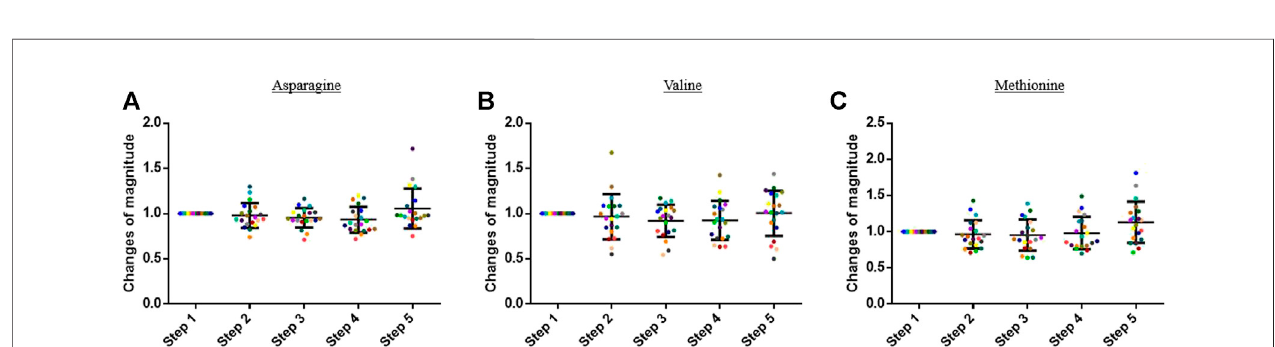
FIGURE 4 | Graphs representing the “ changes of magnitude ” obtained during the fi ve steps of the study. Step 1: before physical exercise, step 2: after 400-m warm-up and 800-m running, step 3: after the completion of 1,600-m running, step 4: 30 min after fi nishing the exercise, and step 5: 60 min after fi nishing the exercise. Each color represents one participant. Black lines represent the mean ± SD of the change of magnitude factor obtained at each step ( n (cid:2) 20). (A) Asparagine, (B) valine, and (C) methionine: examples of compound for which no change in blood concentration was observed during the study.